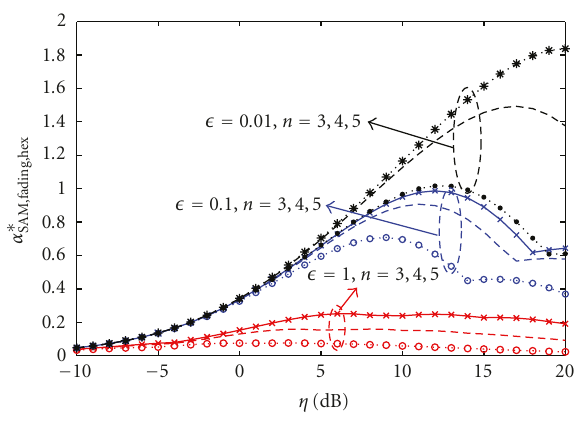
Figure 5: The ( p , q )-optimized α SAM,fading,hex in bits-meters/s/Hz/ node versus η for the hexagonal topology under SNR 0 = 30dB and ρ = 1.